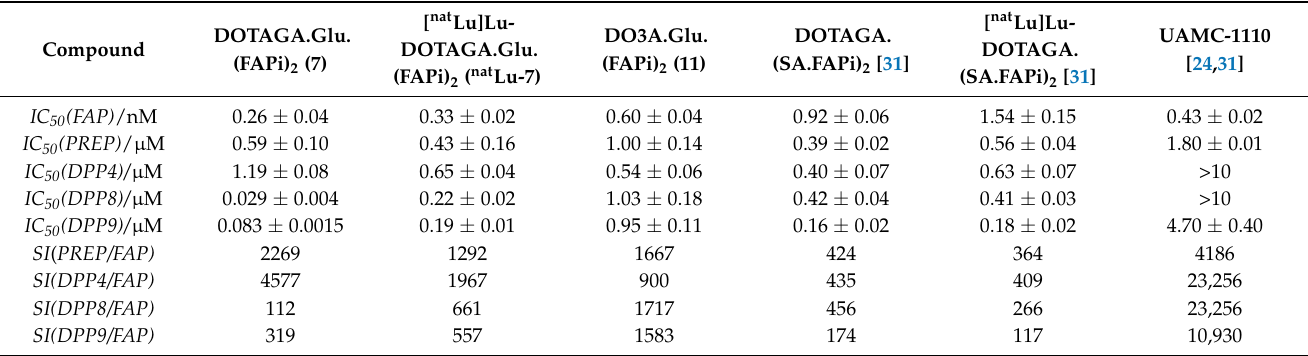
Table 3. IC 50 value and selectivity index (SI) of different FAP inhibitors: DOTAGA.Glu.(FAPi)